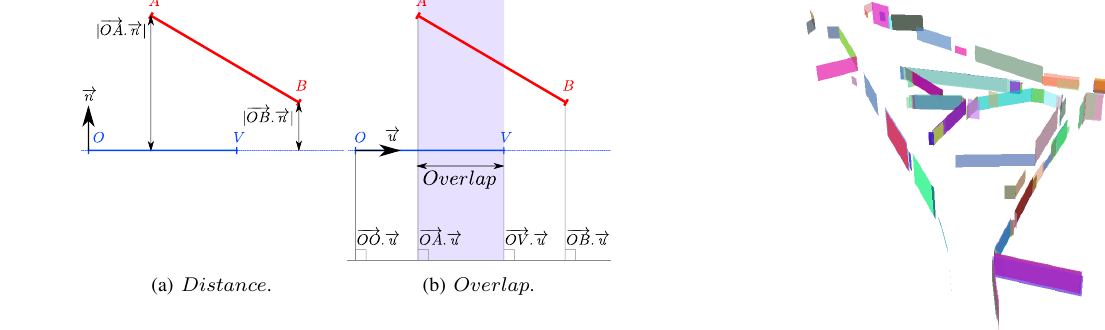
Figure 12: Detected rectangles over the whole dataset.